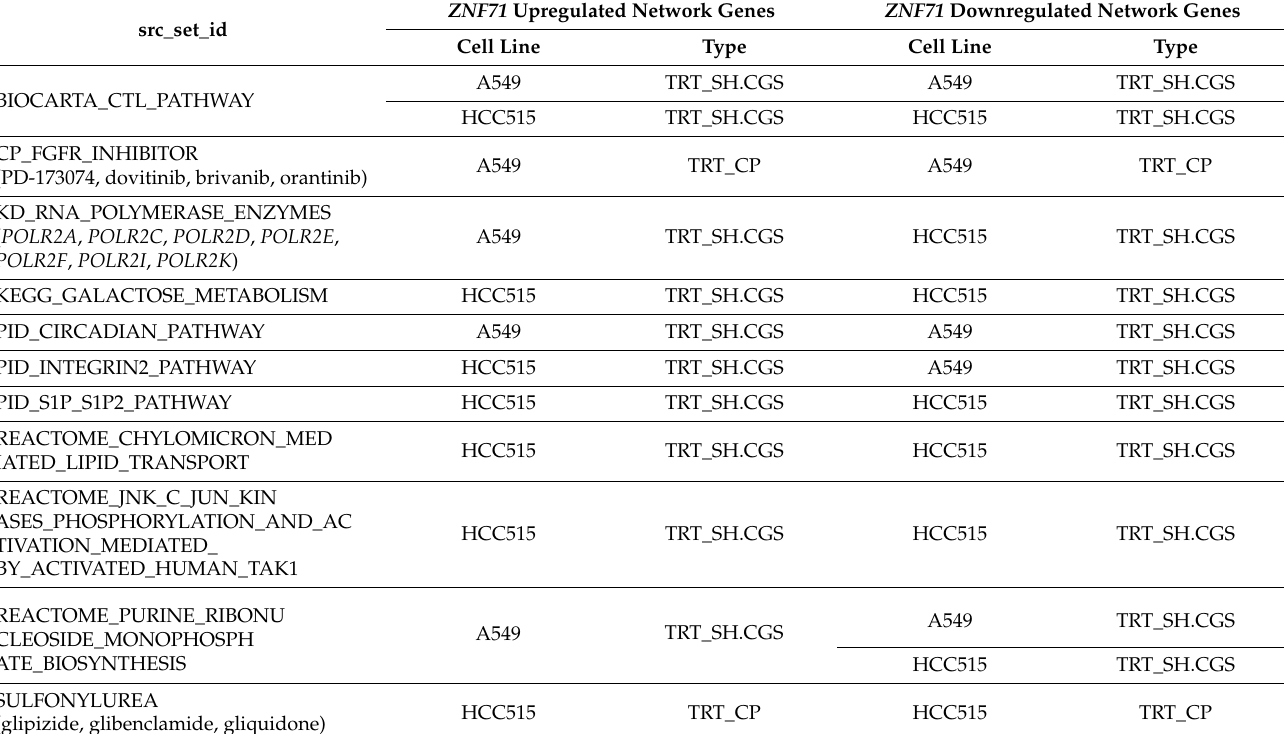
Table 3. The common significant ( p < 0.05, connectivity score > 0.9) functional pathways from CMap using ZNF71 up-regulated network genes (Figure 5A) and ZNF71 down-regulated network genes (Figure 5B) as